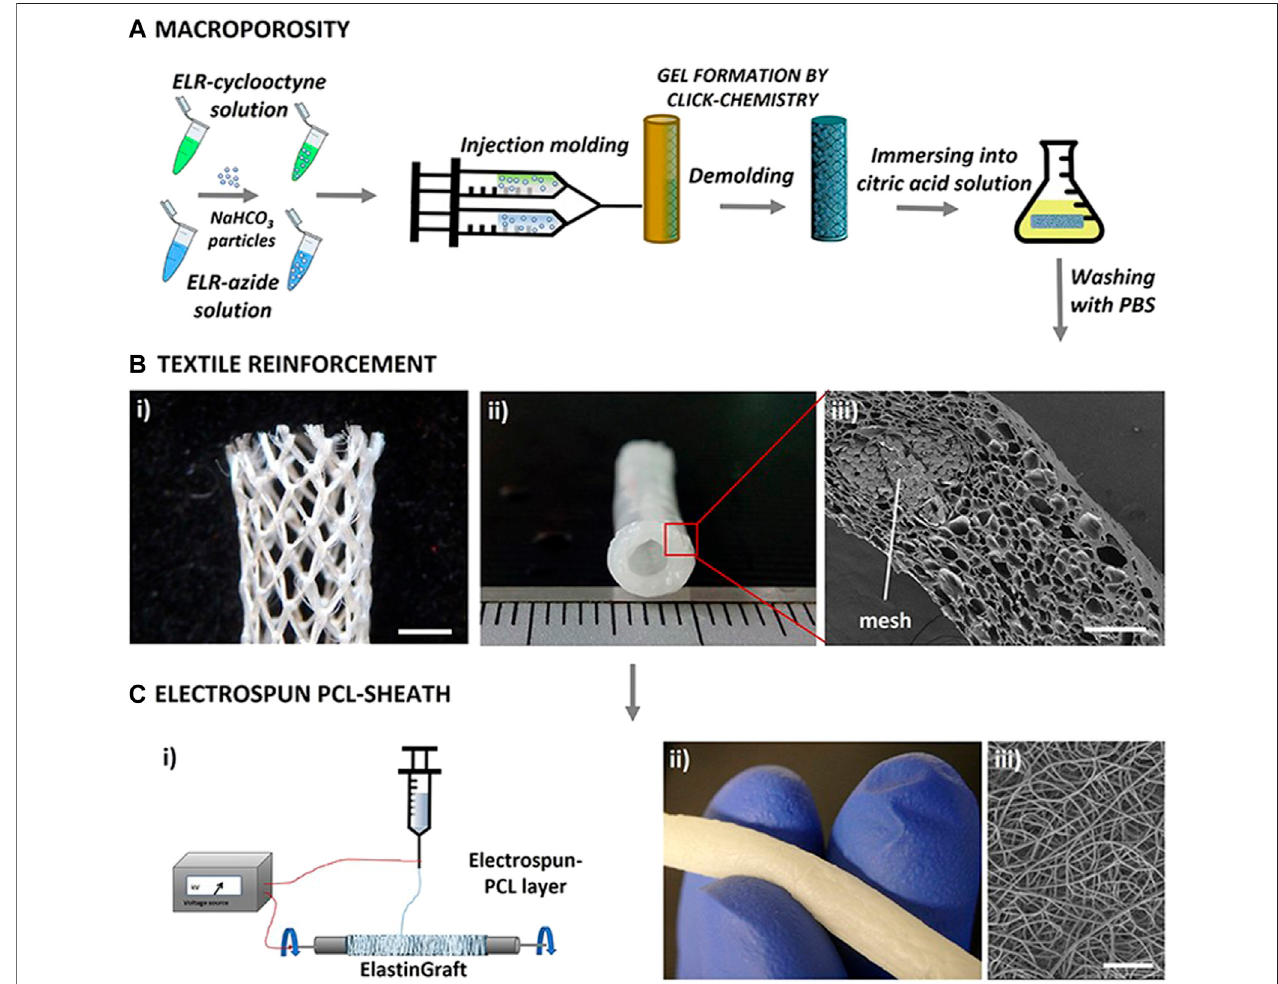
FIGURE 4| Fabrication method ofporous tubular scaffolds from elastin-like recombinamers bysalt leaching/gasfoamingtechnique and electrospinning [modi fi ed from (Fernández-Colino et al., 2019)].